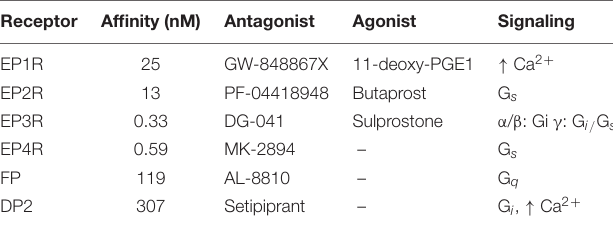
TABLE 1 | Overview of prostanoid receptors and pharmacology. Receptor Affinity (nM)